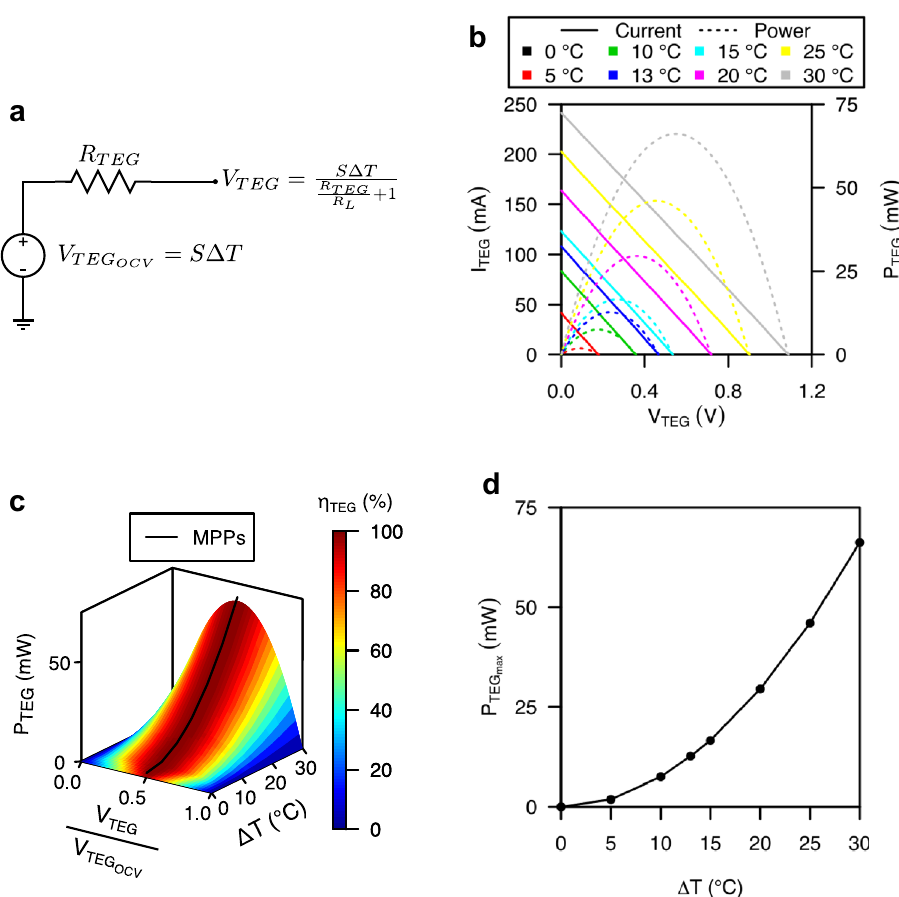
Figure 1. TGM-127-1.0-2.5 thermoelectric generator experimental characterization. ( a ) Simplified lumped electrical model of a general-purpose thermoelectric generator. ( b ) Thermoelectric generator’s polarization curves for different temperature gradients ( (cid:31) T ). ( c ) 3D plot of the power outputted by the thermoelectric generator ( P TEG ), its efficiency ( η TEG ) and the maximum power points versus its polarization voltage ( V TEG ) normalized respect its open-circuit voltage ( V TEG OCV ), and the temperature gradient ( (cid:31) T ). ( d ) Transfer function of temperature gradient ( (cid:31) T ) to power at maximum power point ( P TEG max